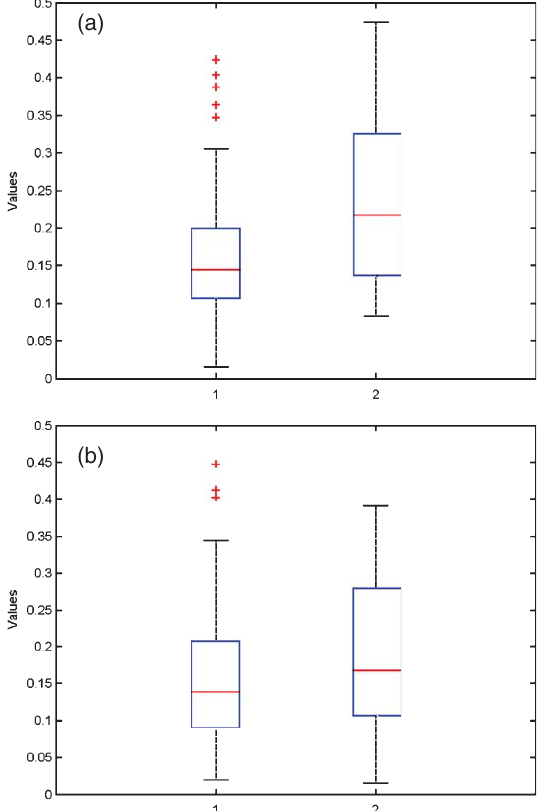
Fig. 2. Boxplot of the feature distribution of the adaptive feature AF − for good (1) and poor (2) prognosis cases. Boxplots are shown for (a) the learning set and (b) the validation set. Outliers are plotted individually (+). (Colours are visible in the online version of the article;